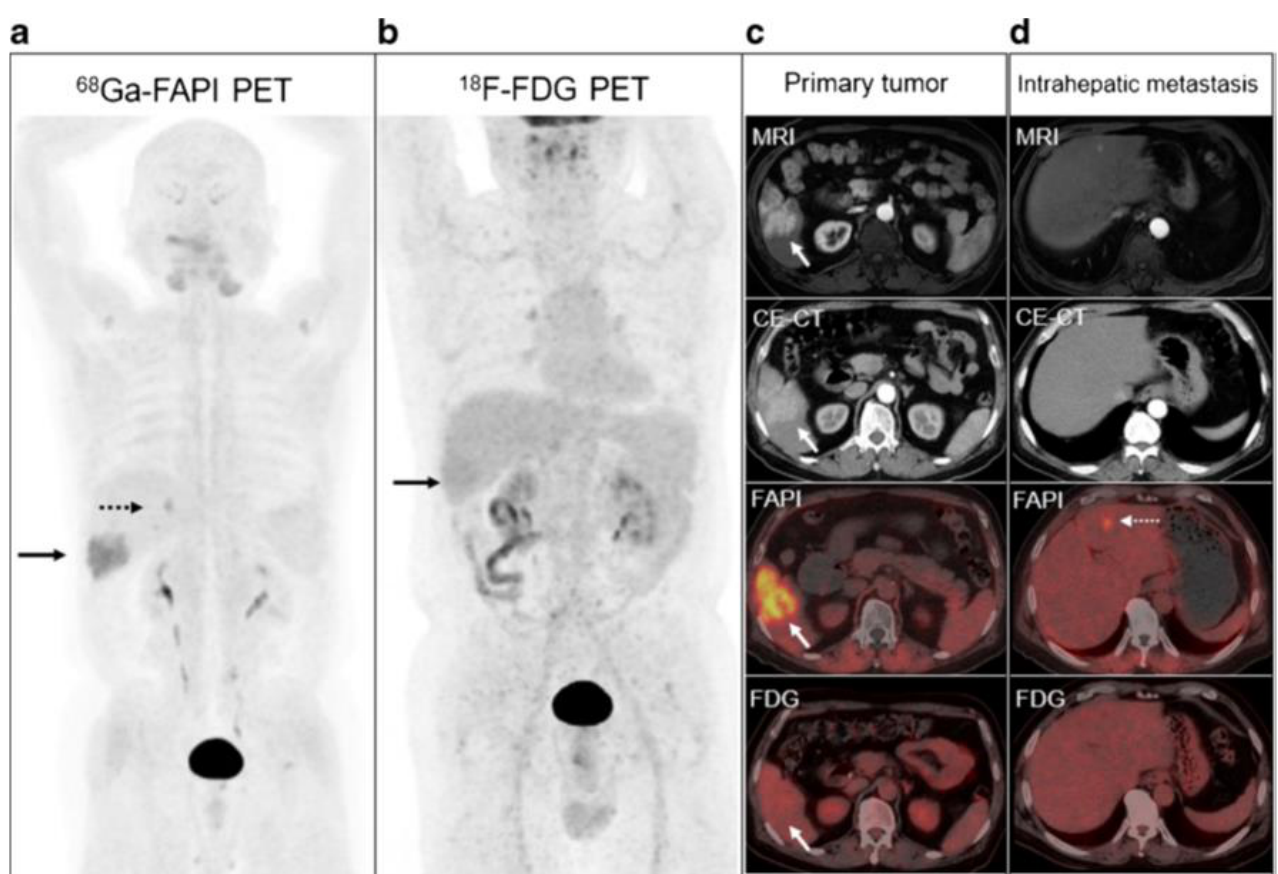
Figure 3. Patient with hepatitis B virus infection for initial staging of moderately differentiated HCC. 68 Ga FAPI-04 ( a ), [ 18 F]-FDG PET/CT ( b ), and MRI and contrast-enhanced CT (CE-CT) ( c ) concordantly showed the primary lesion at the right lower lobe (solid arrows). An extra 0.9-cm metastasis at the left internal lobe (dotted arrows) confirmed on 68 Ga FAPI-04 PET/CT and liver MRI was not shown on CE-CT or [ 18 F]-FDG PET/CT ( d ). (images reproduced with permission from [70] ).